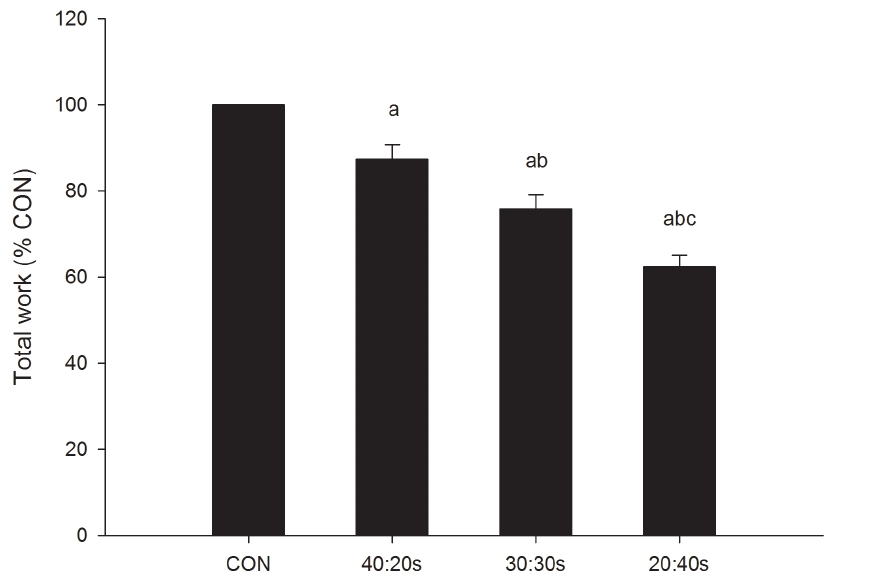
Figure 1. Total work. Total work expressed as a % of CON value, for the 4 experimental protocols. (a) P , 0.05 vs. CON. (b) P , 0.05 vs. 40:20s. (c) P , 0.05 vs.